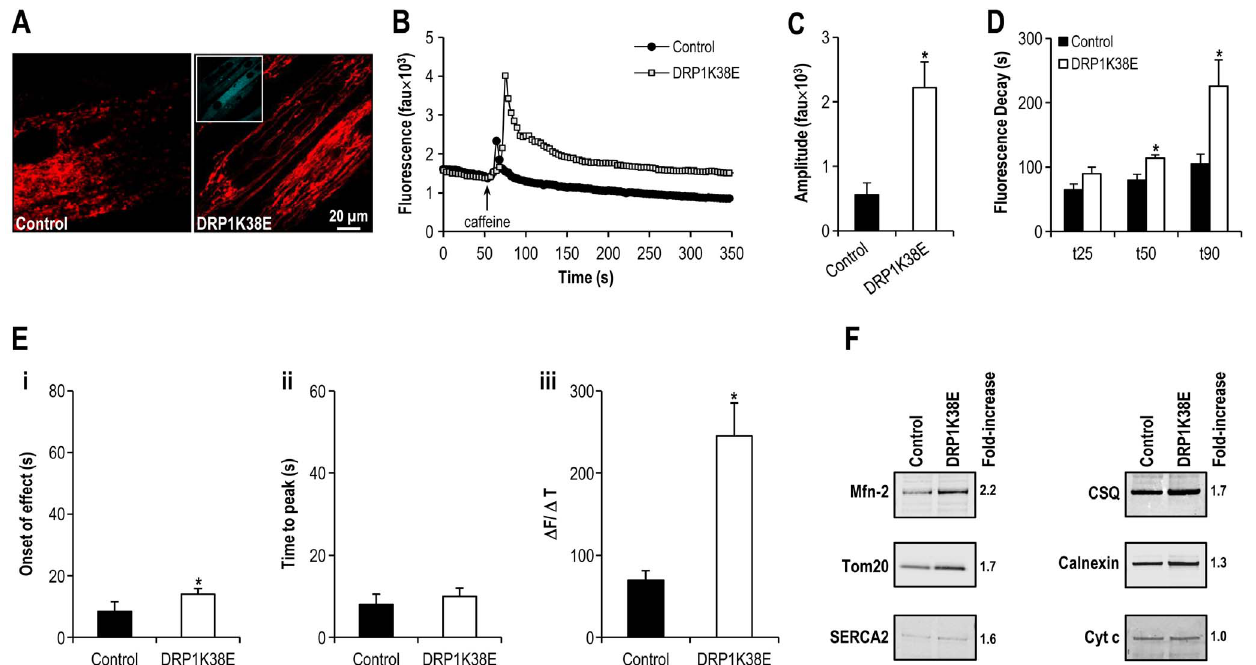
Figure 6. Altered mitochondrial plasticity results in altered SR calcium handling. Panel A: Confocal microscopy images of differentiated C2C12 myotubes expressing DRP1K38E, and loaded with TMRE. Panel B: Representative tracings of the fluorescence profile of myotubes loaded with fluo-4 prior to the application of caffeine to trigger SR calcium release (DRP1K38E v control). Panel C: Objective mean quantitative data for fluorescence resulting from caffeine induced calcium release (DRP1K38E v. control). Panel D: Histogram displaying the mean quantitative data relating to the normalization of fluorescence following caffeine application (DRP1K38E v control). Panel E: Objective mean quantitative data for fluorescence kinetics profile resulting from caffeine induced calcium release (DRP1K38E v. control). Panel F: Immunoblots confirming increased MAM formation in differentiated C2C12 myotubes expressing DRP1K38E. Mitochondria were isolated, and 30 m g of protein (pooled from 5 separate experiments) were processed for gel electrophoresis. Primary antibodies used were against Mfn-2, Tom20, SERCA2, CSQ, calnexin and cytochrome c (cyt c, loading control). * Denotes p , 0.01 – 0.001 ANOVA, n=40 per group.